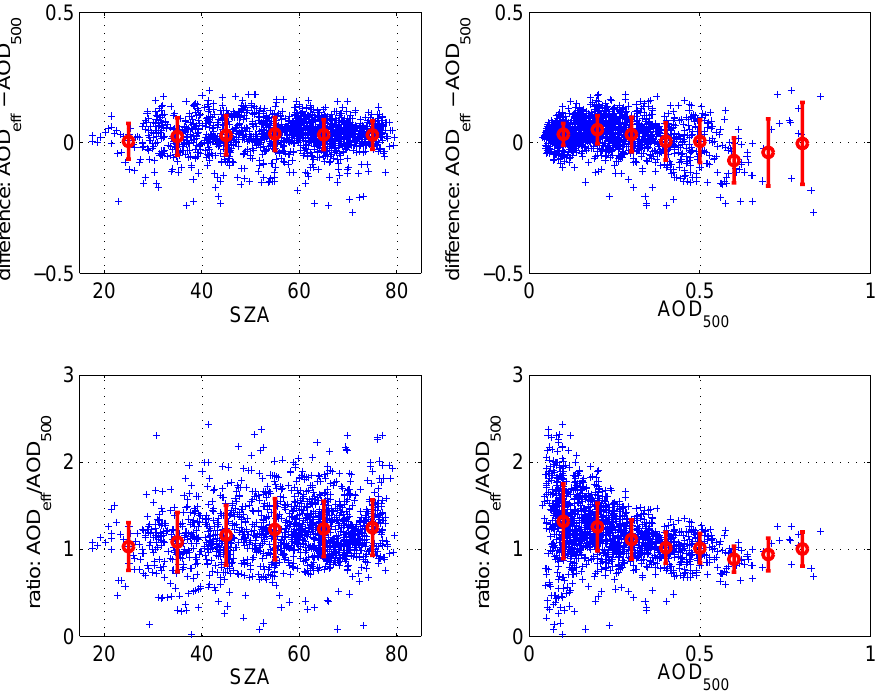
Fig. 3. Difference between and ratio of the pyranometer-based AOD eff and AERONET AOD 500 as a function of AOD 500 and solar zenith angle (SZA). Group mean values and standard deviation are shown with red open circles and error bars.